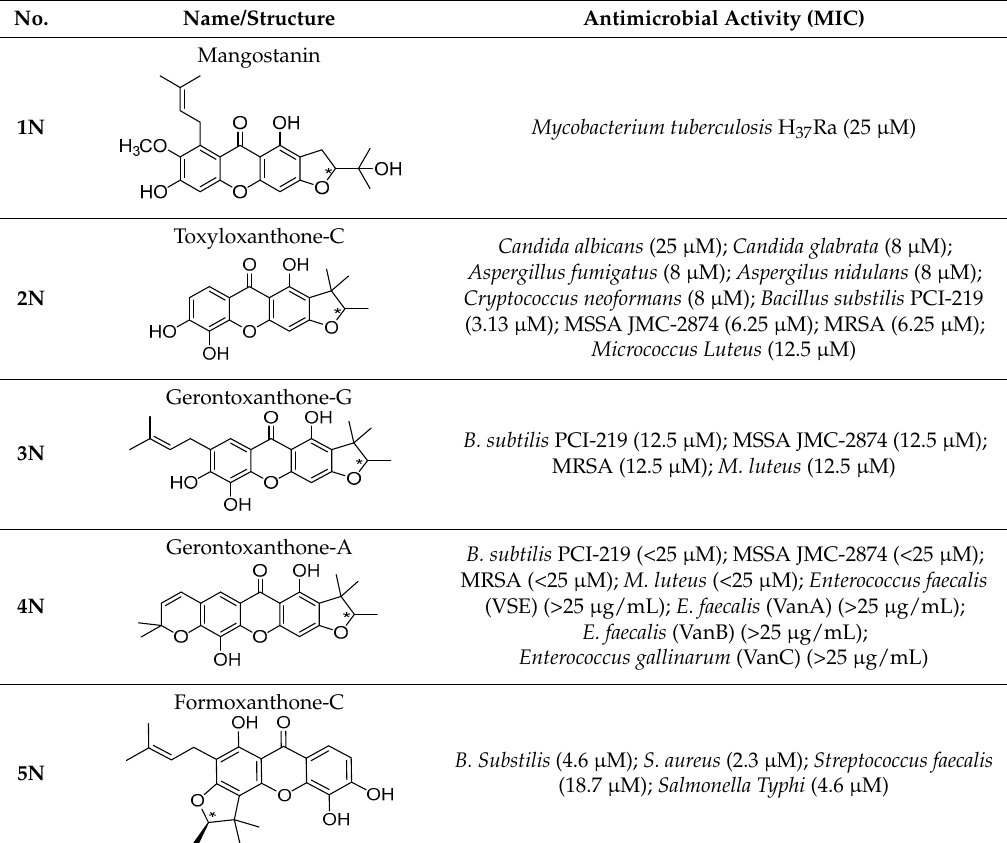
Table 1. Antimicrobial activity of natural CDXs with furan groups.